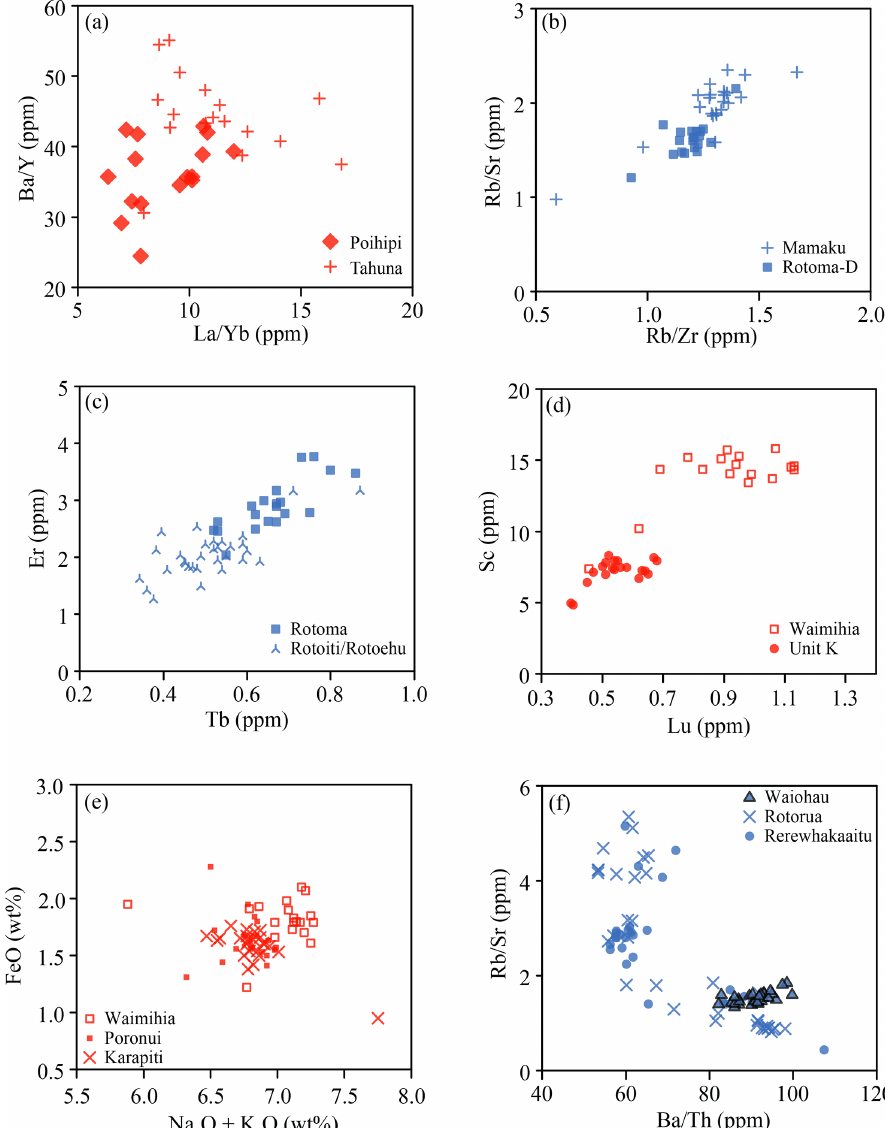
Figure 14. Biplots for glass analyses for specific tephras which have very similar compositions and similar ages (see text for discussion and Table 5 for alternative elements). Plots show examples of the elements in glass that enable these tephras to be separated: (a) Poihipi and Tahuna (from TVC); (b) Mamaku and Rotoma-D (from OVC; note no trace-element data were obtained for Rotoma-P); (c) Rotoma and Rotoiti/Rotoehu (from OVC); (d) Waimihia and Unit K (from TVC); (e) Waimihia, Poronui and Karapiti – note that Poronui and Karapiti are indistinguishable using glass chemistry; and (f) Waiohau, Rerewhakaaitu and Rotorua – note that Rerewhakaaitu and Rotorua are indistinguishable using glass chemistry. All major-element data are presented on a normalised basis, and total iron is expressed as